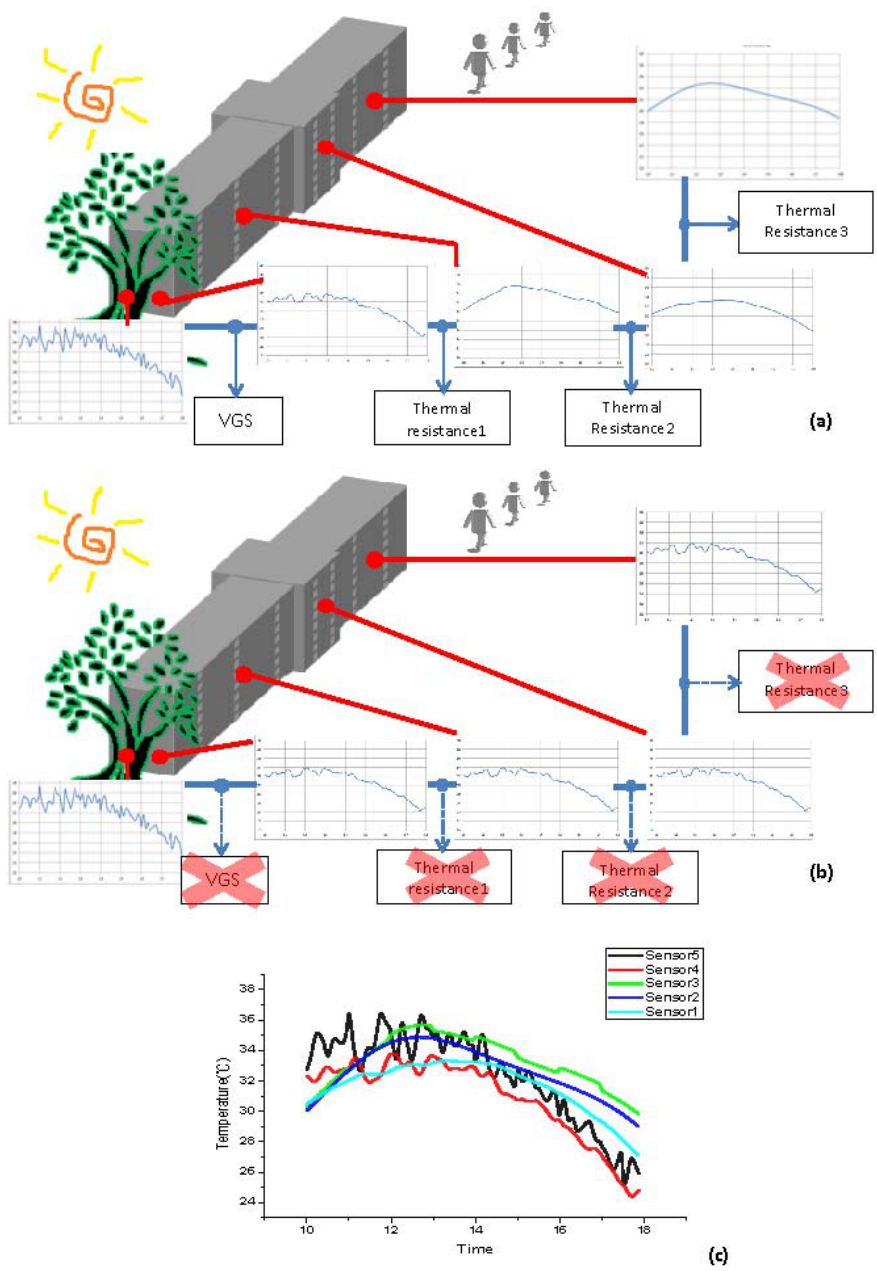
Figure 8. System